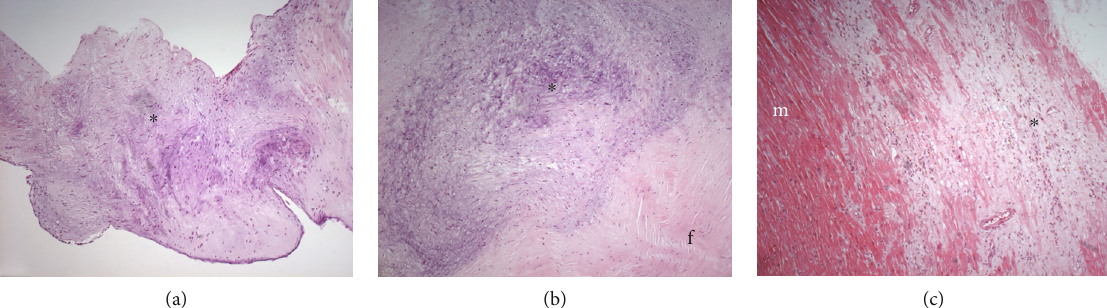
Figure 2: Photomicrographs from tricuspid valve. (a, b) Myxomatous degeneration ( ∗ ) and fi brosis (f) of the spongiosa layer. (c) Healed infarct ( ∗ ) in papillary muscle